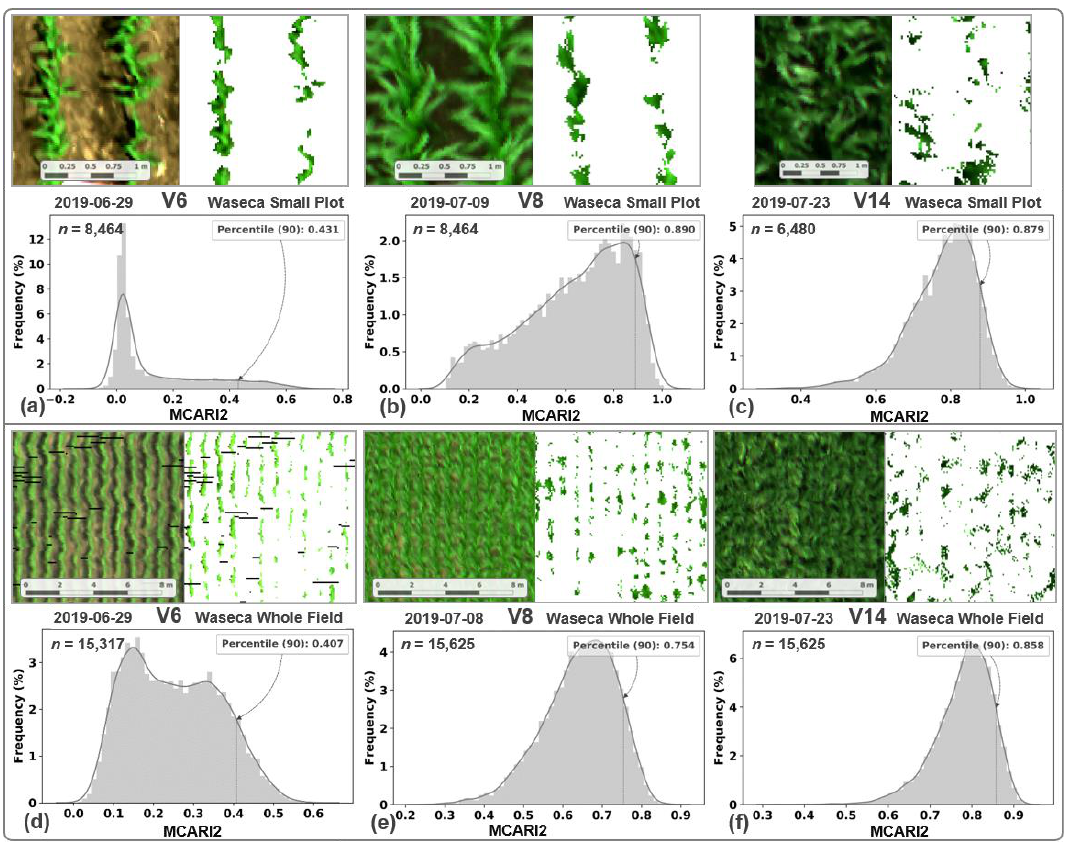
Figure 2. Aerial hyperspectral images (represented as a true color render) for the Waseca small plot ( a – c ) and Waseca whole field ( d – f ) experiments before and after segmentation at the V6 (a and d), V8 (b and e), and V14 (c and f) development stages. The histograms illustrate the 90th percentile MCARI2 values (Modified Chlorophyll Absorption Ratio Index Improved) for each image, which was used as the threshold for segmentation.